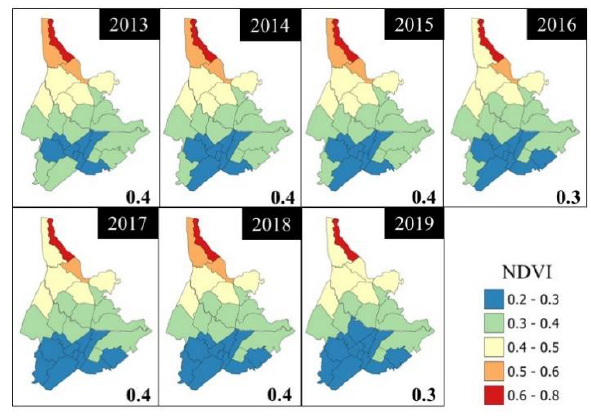
Figure 6. Barangay-level average NDVI maps of Mandaue City